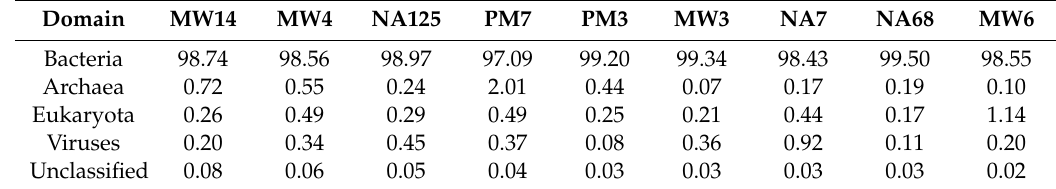
Table 2. Relative abundance (%) of microorganisms at the domain